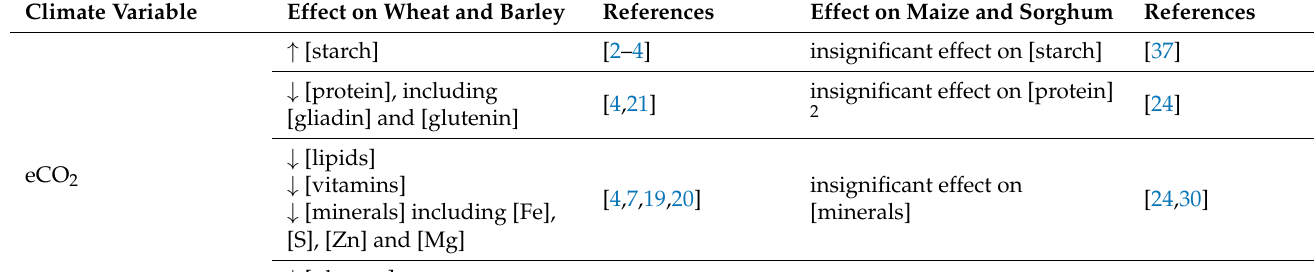
Table 2. Effects of eCO 2 and heat stress and drought on quality in C 3 cereal grains wheat and barley and C 4 cereal grains maize and sorghum. Upwards arrows indicate an increase and downwards arrows indicate a decrease in the corresponding